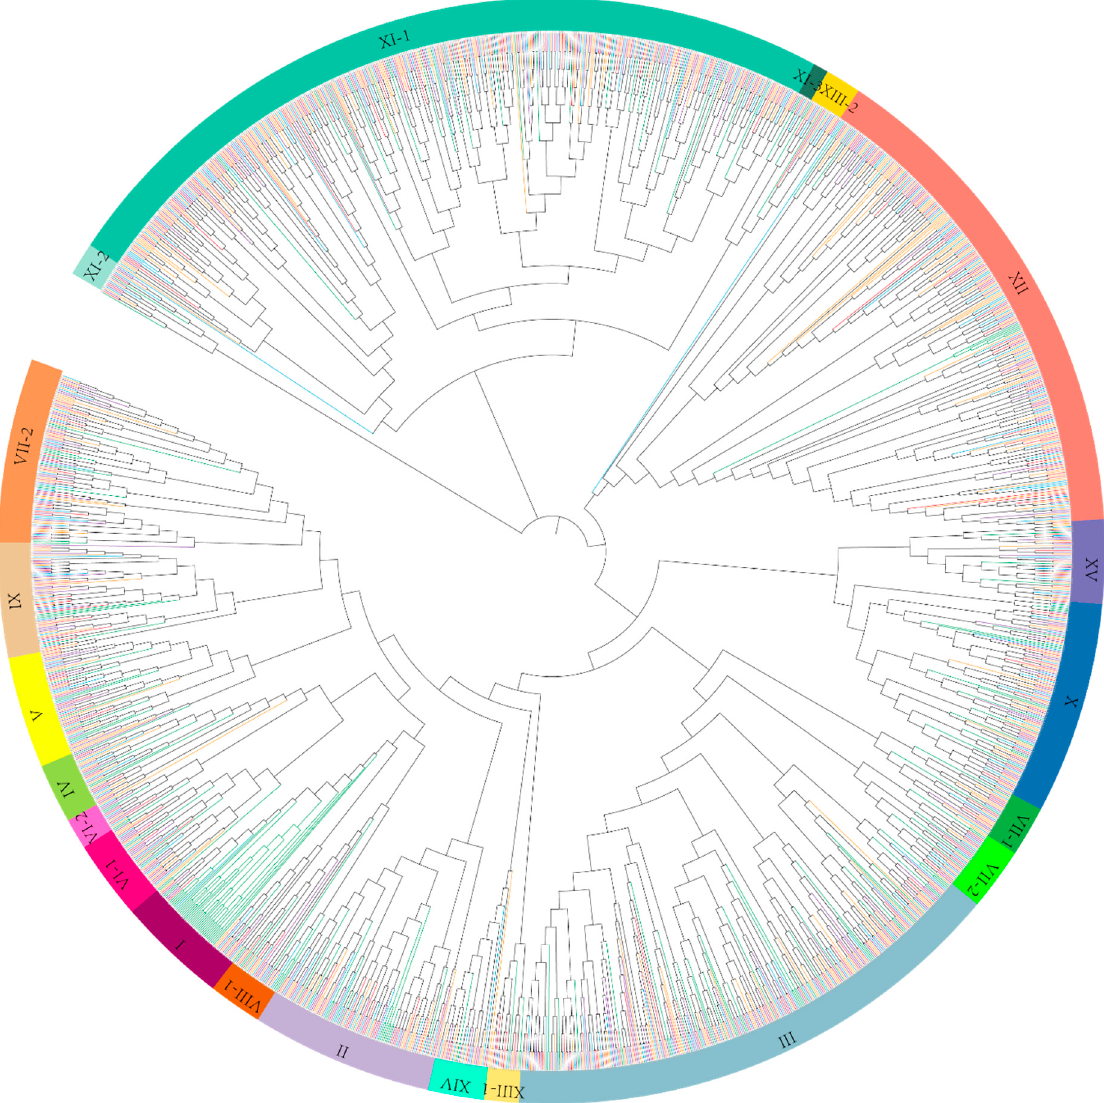
Figure 1. Phylogenetic tree of leucine-rich repeat receptor-like kinases (LRR-RLK) genes from four Gossypium species and Arabidospsis thaliana . The phylogenetic tree was constructed by maximum likelihood (ML) method based on kinase domain amino acid sequences of LRR-RLKs. All LRR-RLK genes were divided into 21 distinct clades, marked by bold curves with different colors. LRR-RLKs from A. thaliana , Gossypium arboreum , Gossypium barbadense , Gossypium hirsutum, and Gossypium raimondii were represented by branches colored within green, red, yellow, purple, and blue,